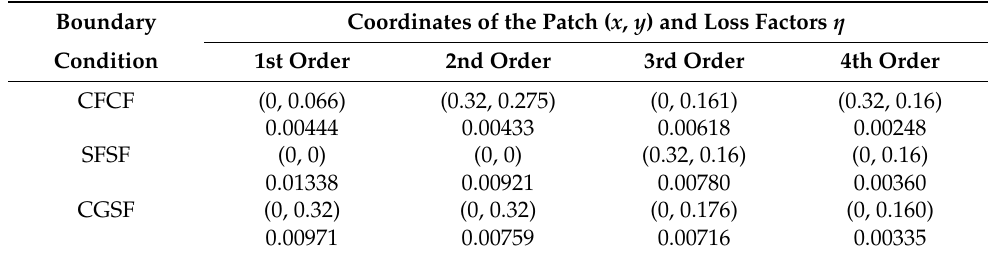
Table 7. The first four loss factors after optimizing the location of the patch for CFCF, SFSF, CGSF. Boundary